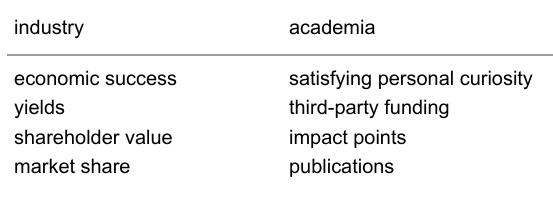
Table 1: Differences in motivation to solve problems in industry and the scientific world. industry